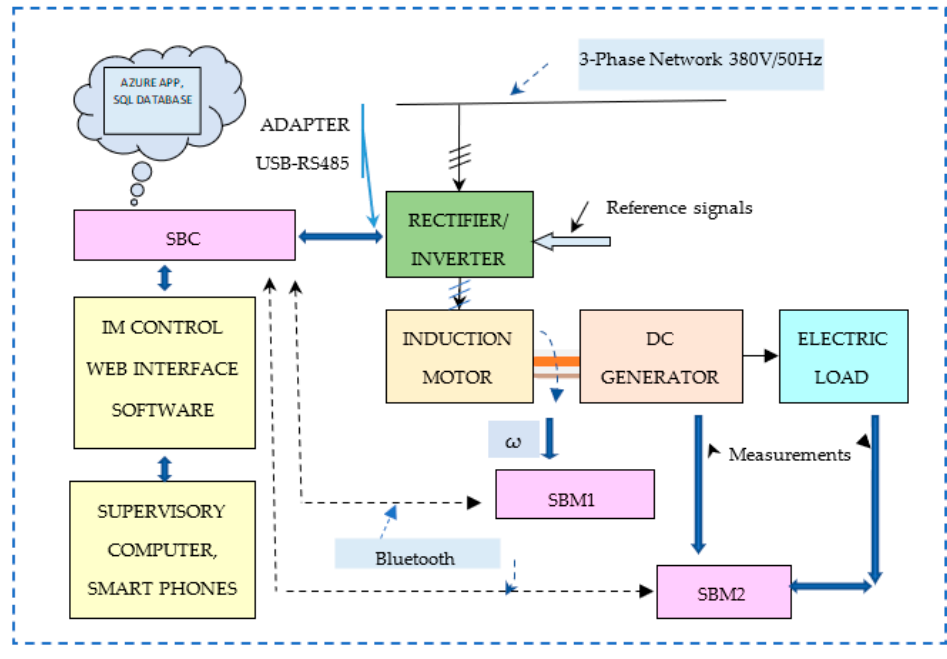
Figure 2. Block Diagram of the Control System of IM Electric Drive with IoT.